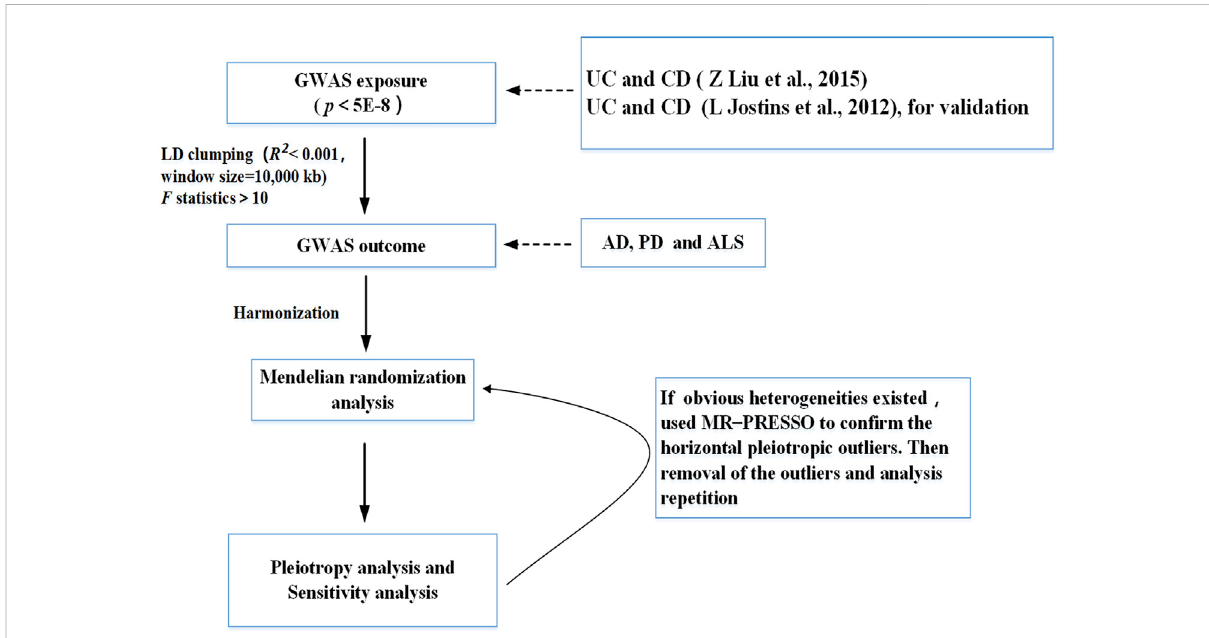
FIGURE 2 Flowchart ofthisMendelianrandomizationstudy.UC,ulcerativecolitis;CD,Crohn ’ sdisease;AD,Alzheimer ’ sDisease; PD,Parkinson ’ sDisease; ALS, Amyotrophic Lateral